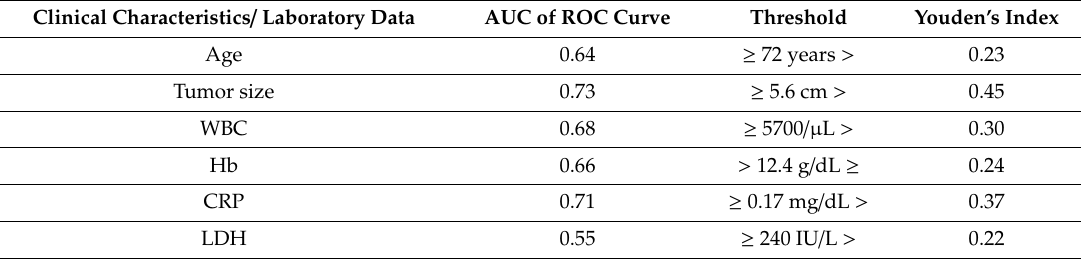
Table 3. AUC, optimal threshold, and Youden’s index for each